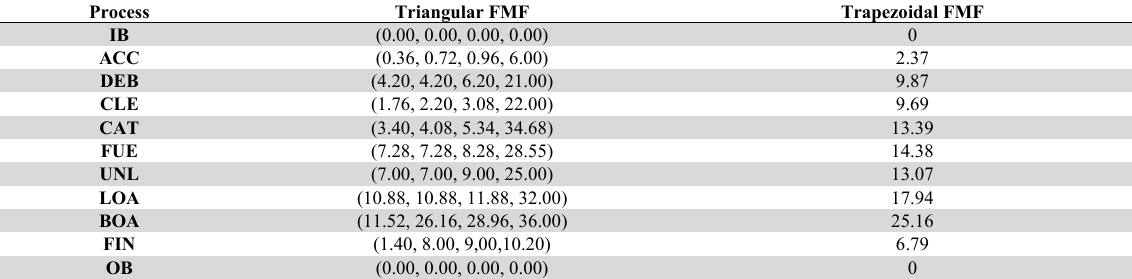
Defuzzification results for each turnaround